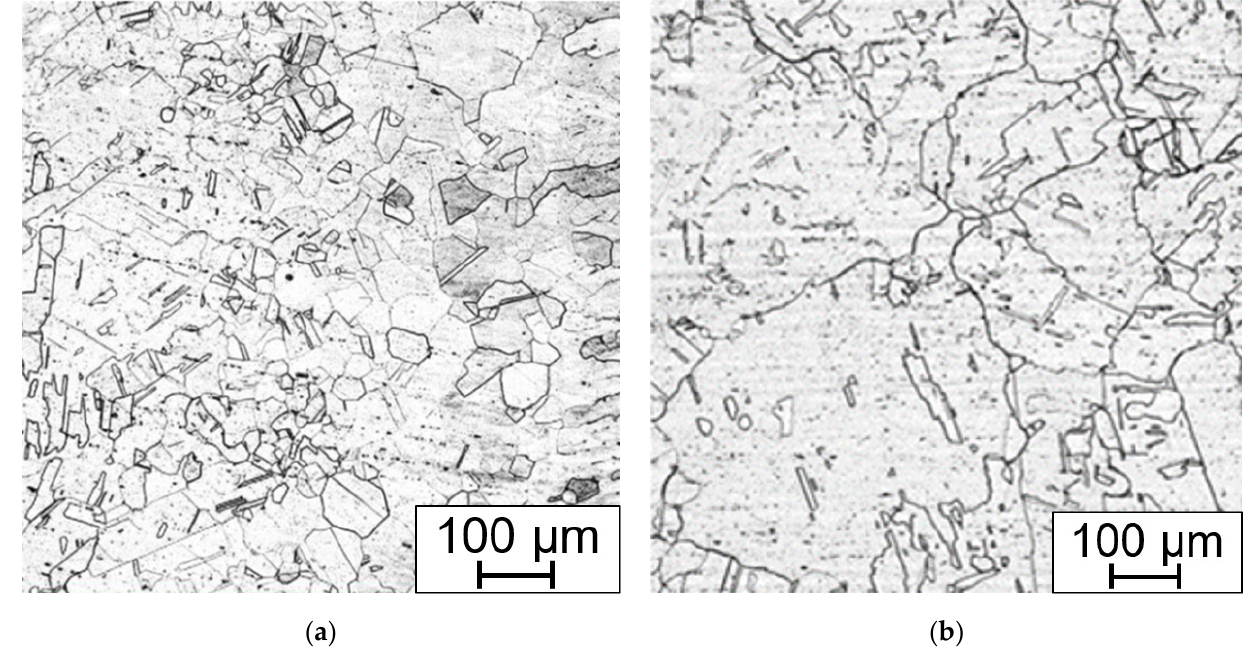
Figure 17. Annealed weld ( a ) HAZ and fusion line on the right; ( b ) annealed areas with coarse grains and annealing induced twining. Electrolytically etched in 10% aq. acetic acid (5 V DC, 10 s).